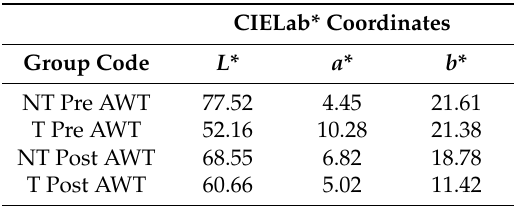
Table 2. CIELab* coordinates measured for tested specimens.